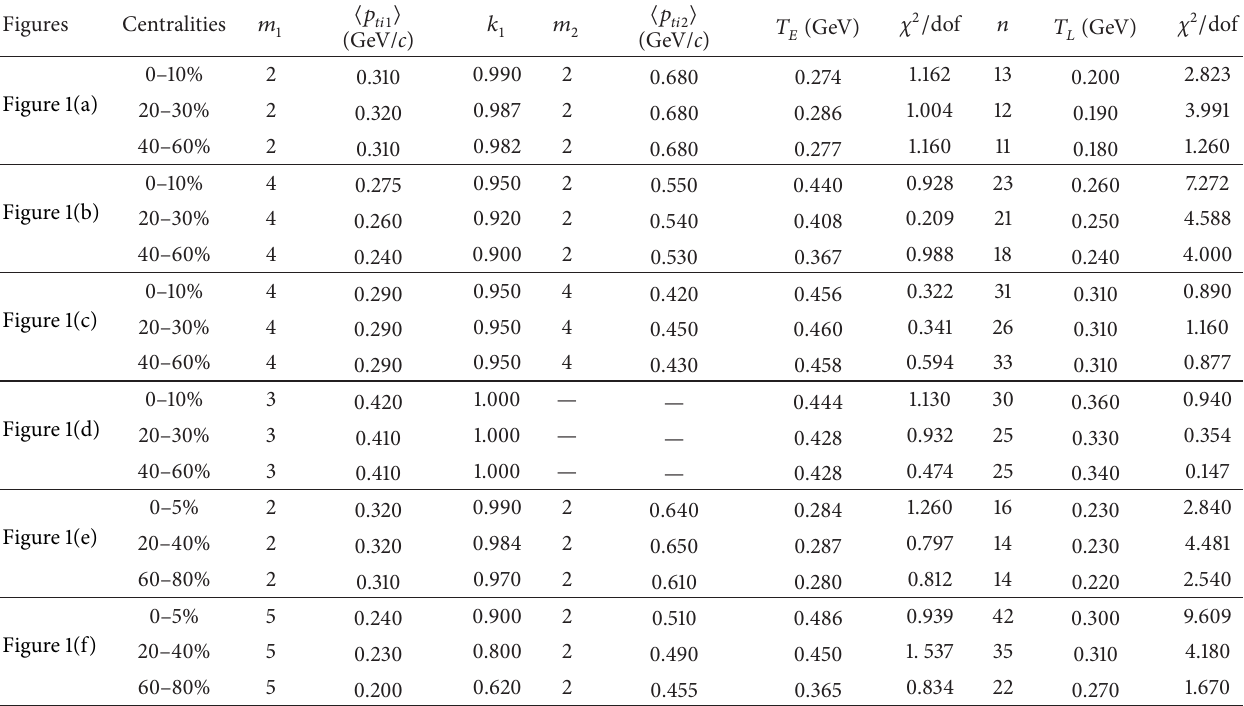
Table 1: Parameter values for the two kinds of curves in Figure 1. The values of 𝜒 2 / dof and extracted temperatures are given. The errors for 𝑚 𝑛 can be neglected, and the relative errors for other parameters are less than 𝑚 1 , 2 , and